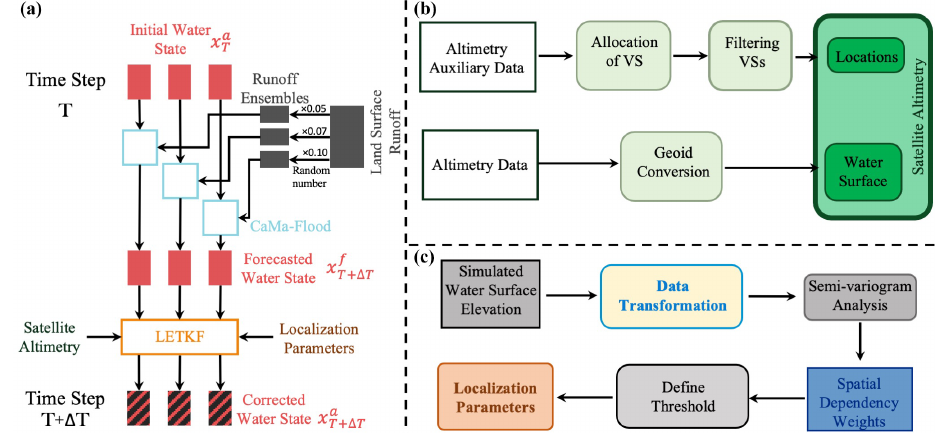
Figure 1. (a) Data assimilation framework, (b) schematic diagram of satellite altimetry preprocessing, and (c) derivation of the localization